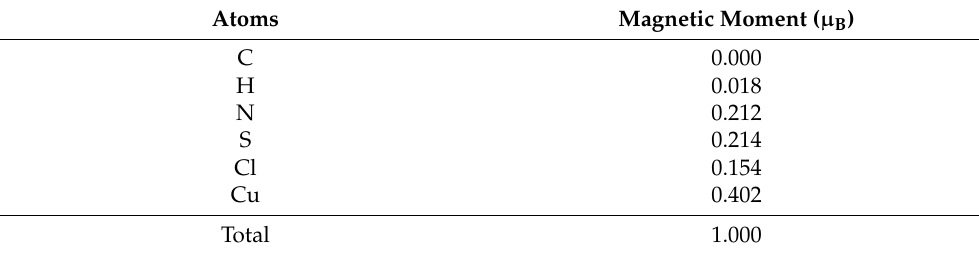
Table 7. Magnetic moments of the different atoms of each monomer of the [{CuLCl} 2 ] dimer in 1 , obtained from Mulliken